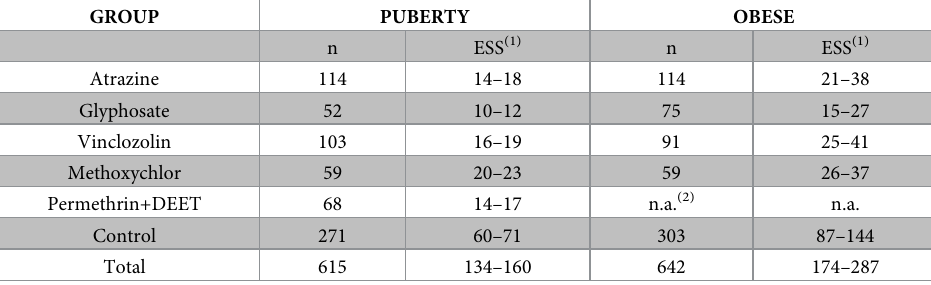
Note (1) The range of the effective sample size (ESS) is determined by the upper and lower points of the confidence intervals for ρ in Table 1. (2)